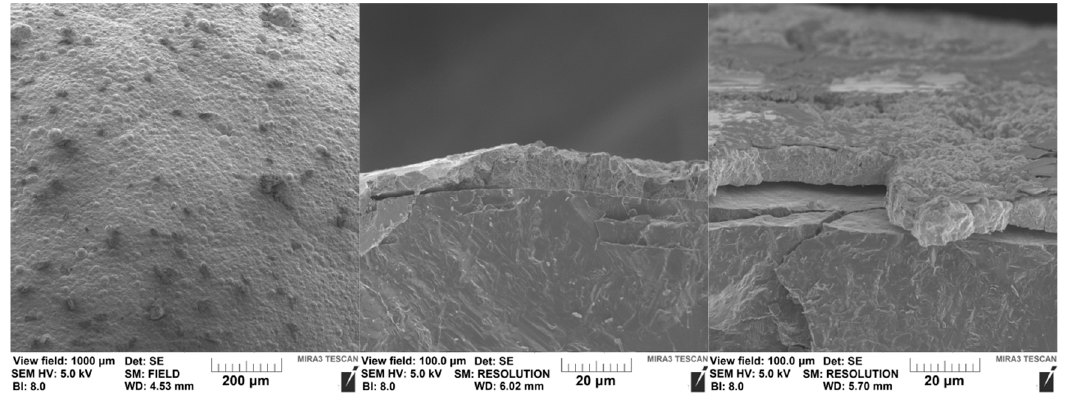
Figure 11. Micrographs of the surface and cleavage of spherical titanium hydride granules modified by copper electrochemical deposition.